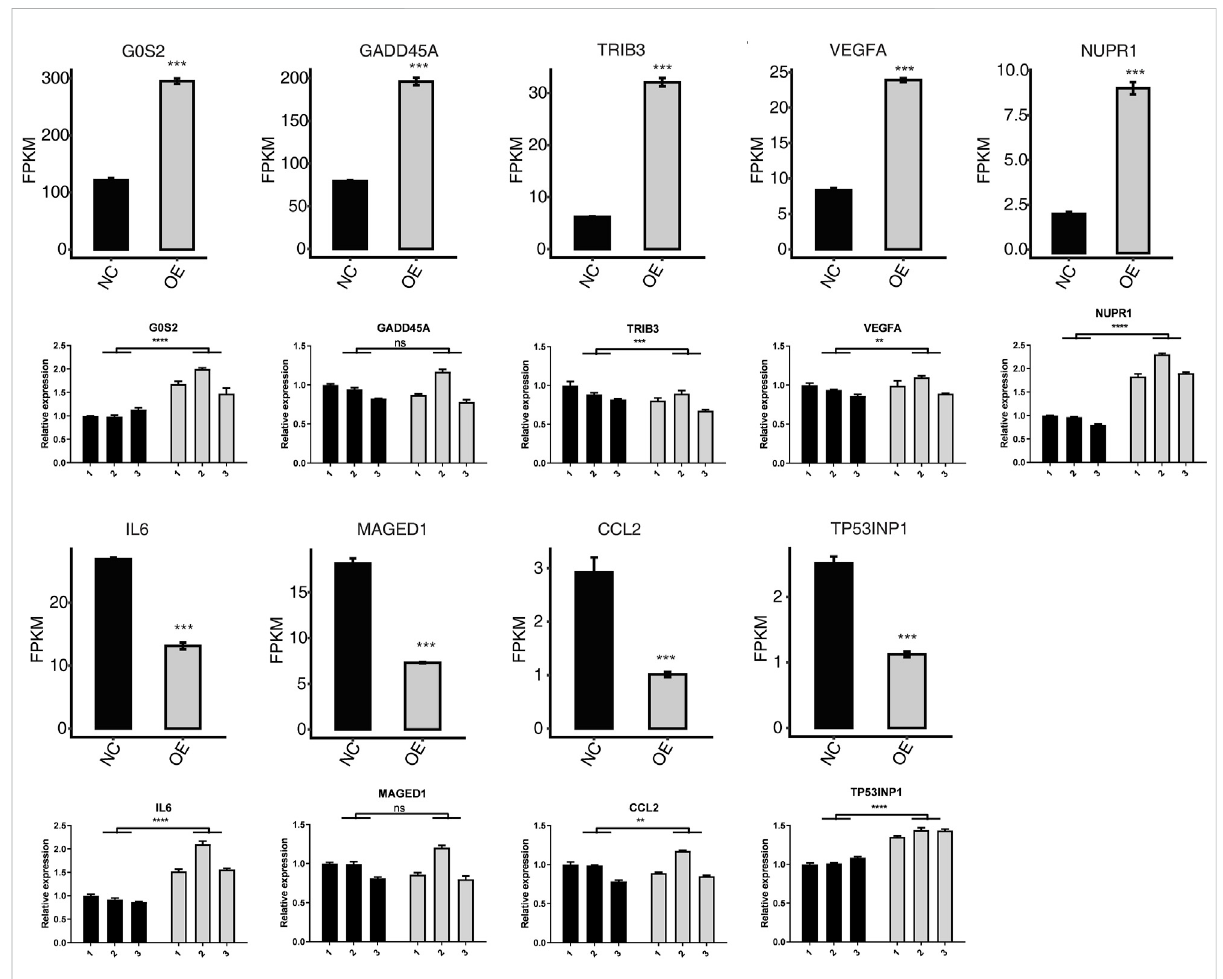
FIGURE 4 Related expression level (FPKM) and RT-qPCR measurement of apoptotic-related DEGs. **** p -value < 0.0001. *** p -value < 0.001. ** p -value <